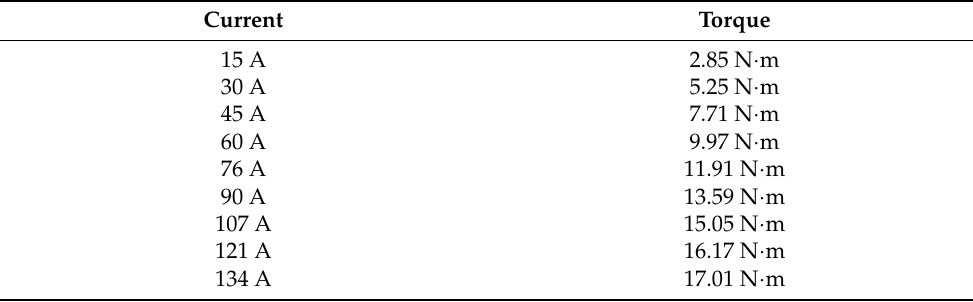
Figure 14 lists the T-I curve of the prototype compared to the simulated motor.